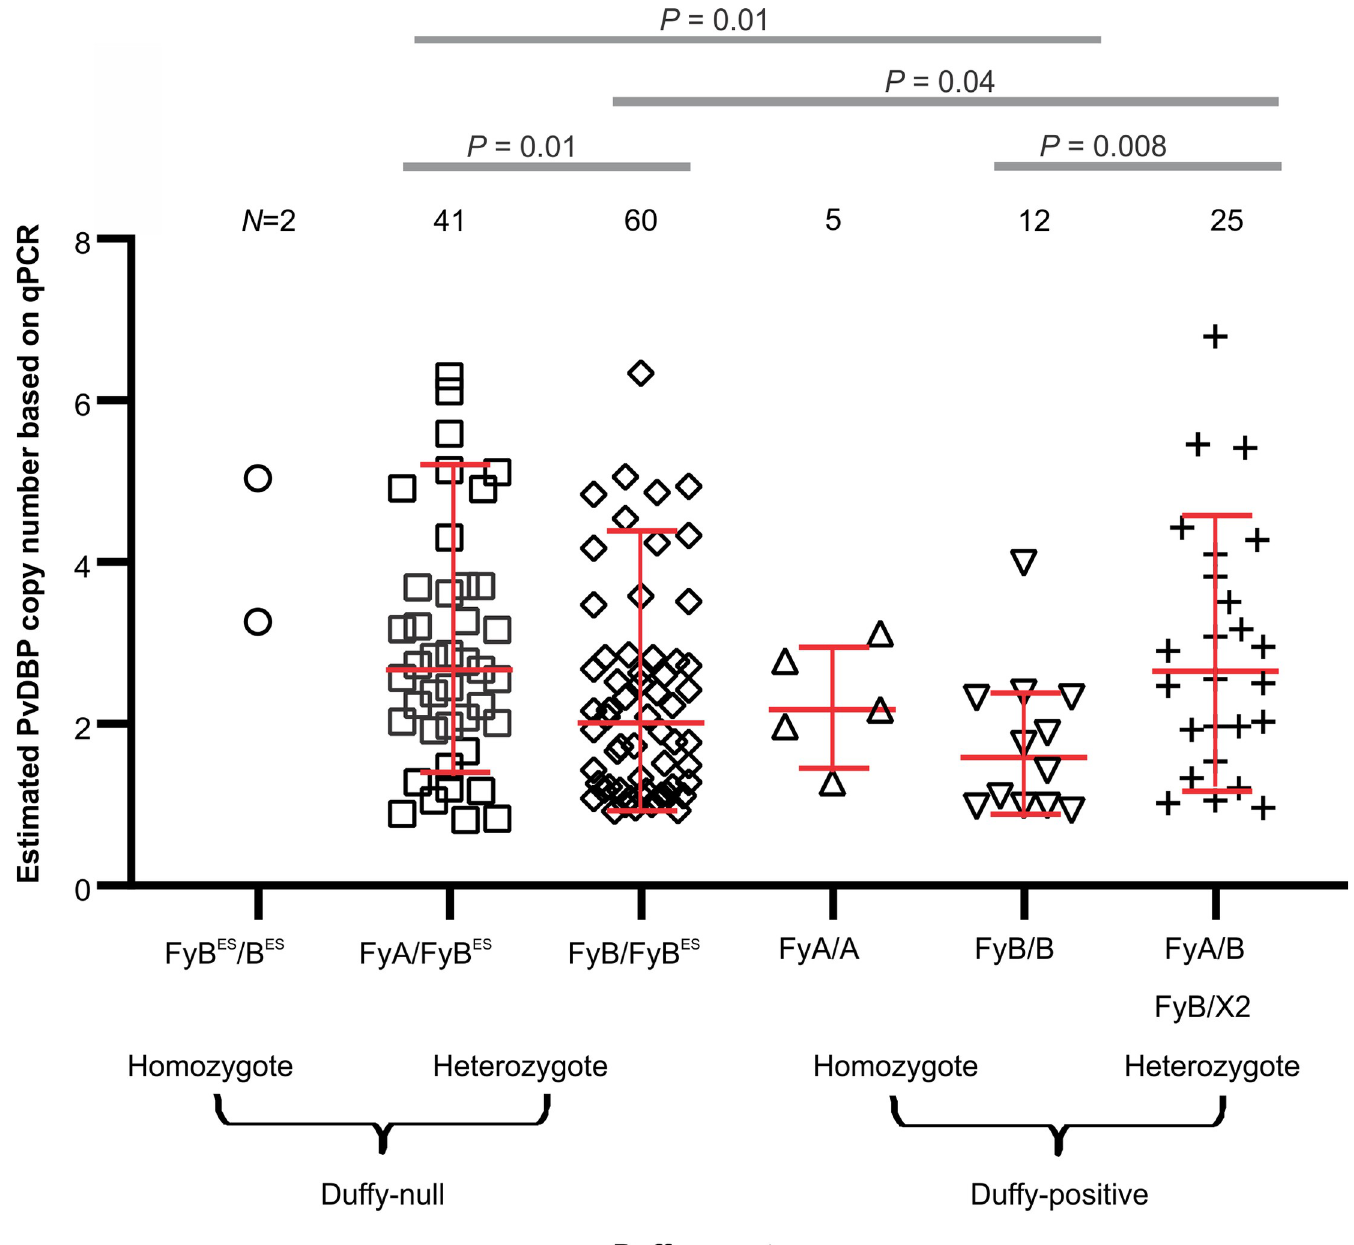
Fig 4. Comparison of PvDBP copy number among symptomatic samples with different Duffy genotypes. These included Duffy-null homozygotes ( FyB ES / B ES ), Duffy-null heterozygotes ( FyA / B ES or FyB / B ES ), Duffy-positive homozygotes ( FyA / A or FyB / B ), and Duffy-positive heterozygotes ( FyA/B or FyB/X2 ). The geometric median and stand deviation of the data were shown for each of the